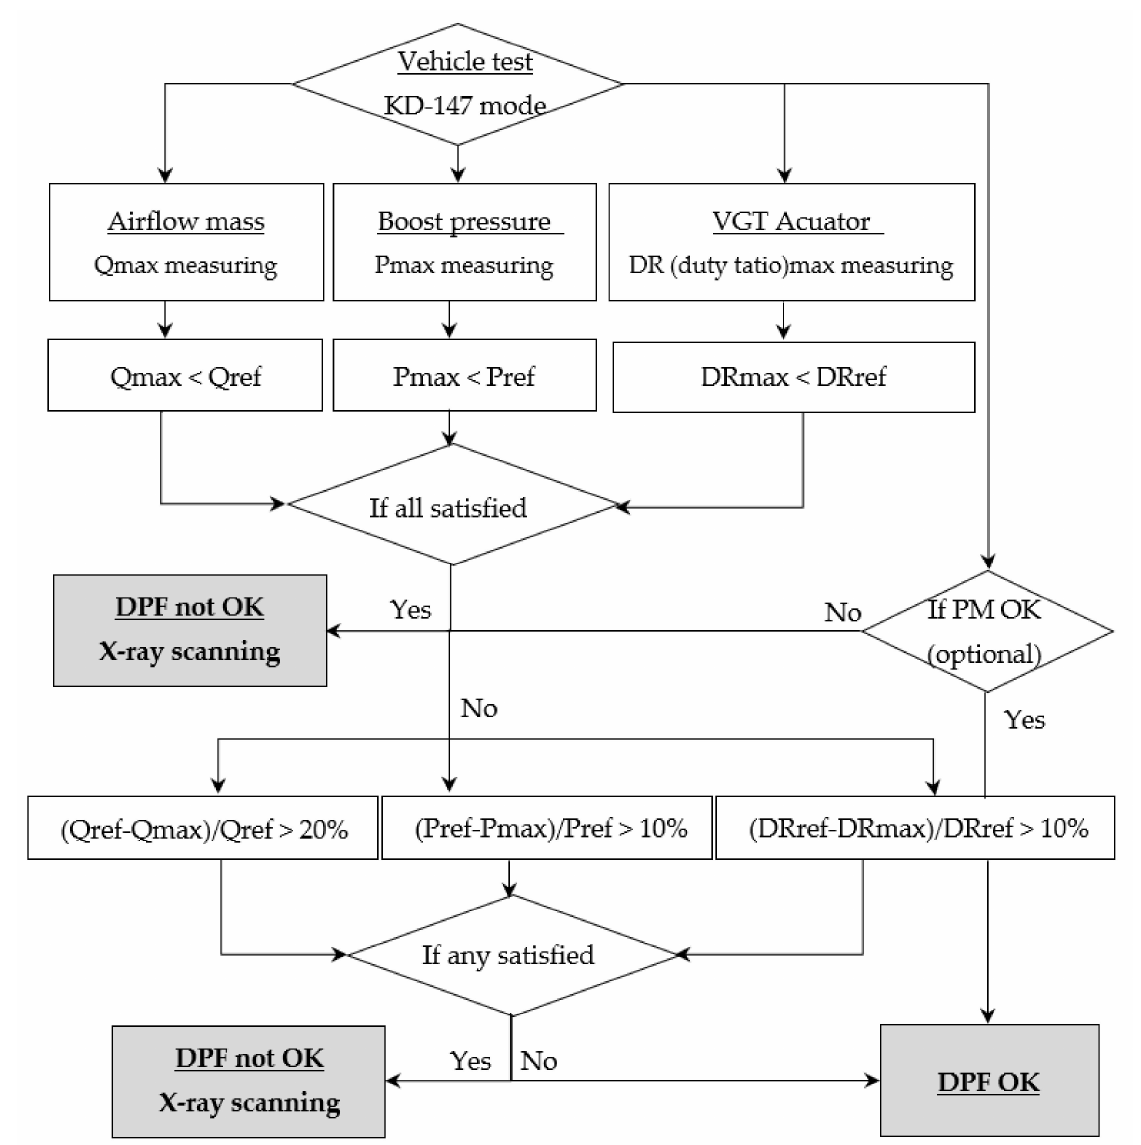
Figure 16. DPF diagnosis algorithm developed in this